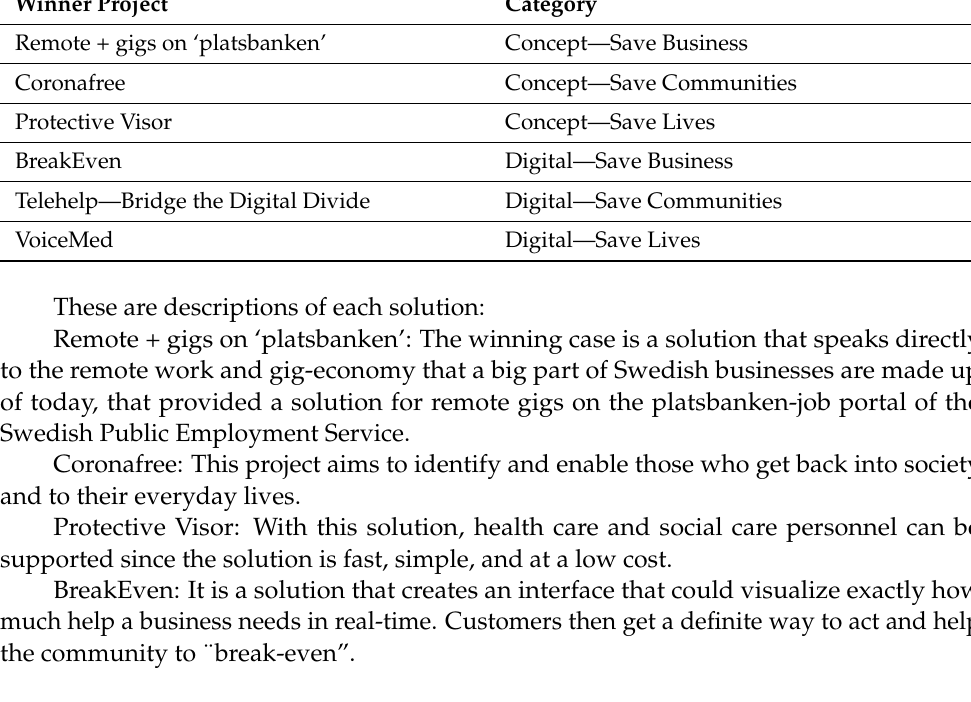
Table 4. Winner list. Winner